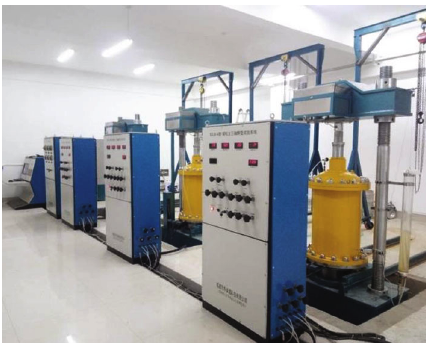
Figure 2: Triaxial testing system